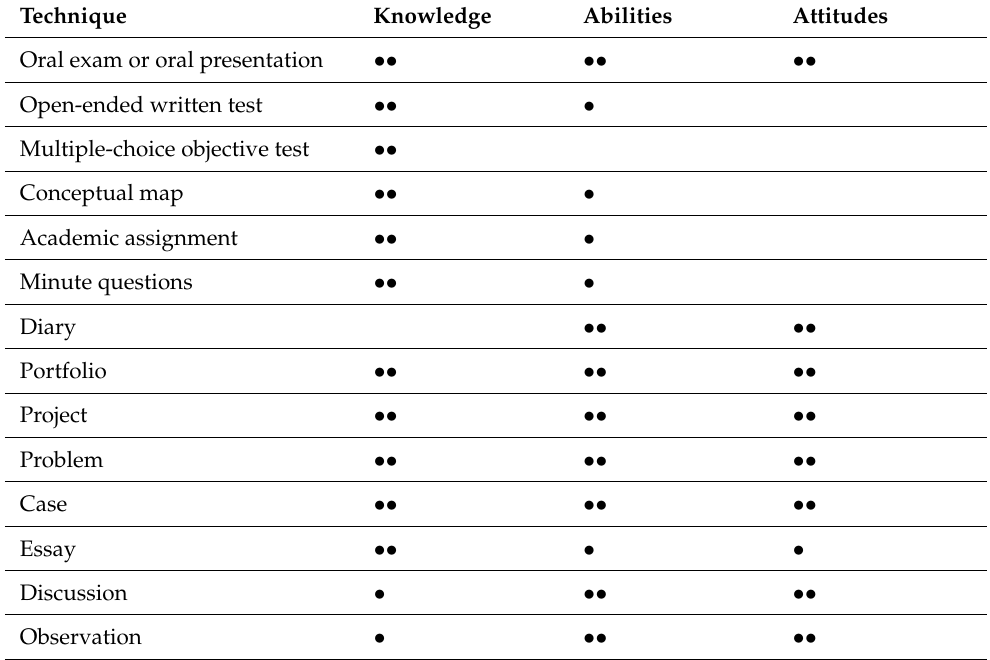
Table 1. Evaluation techniques